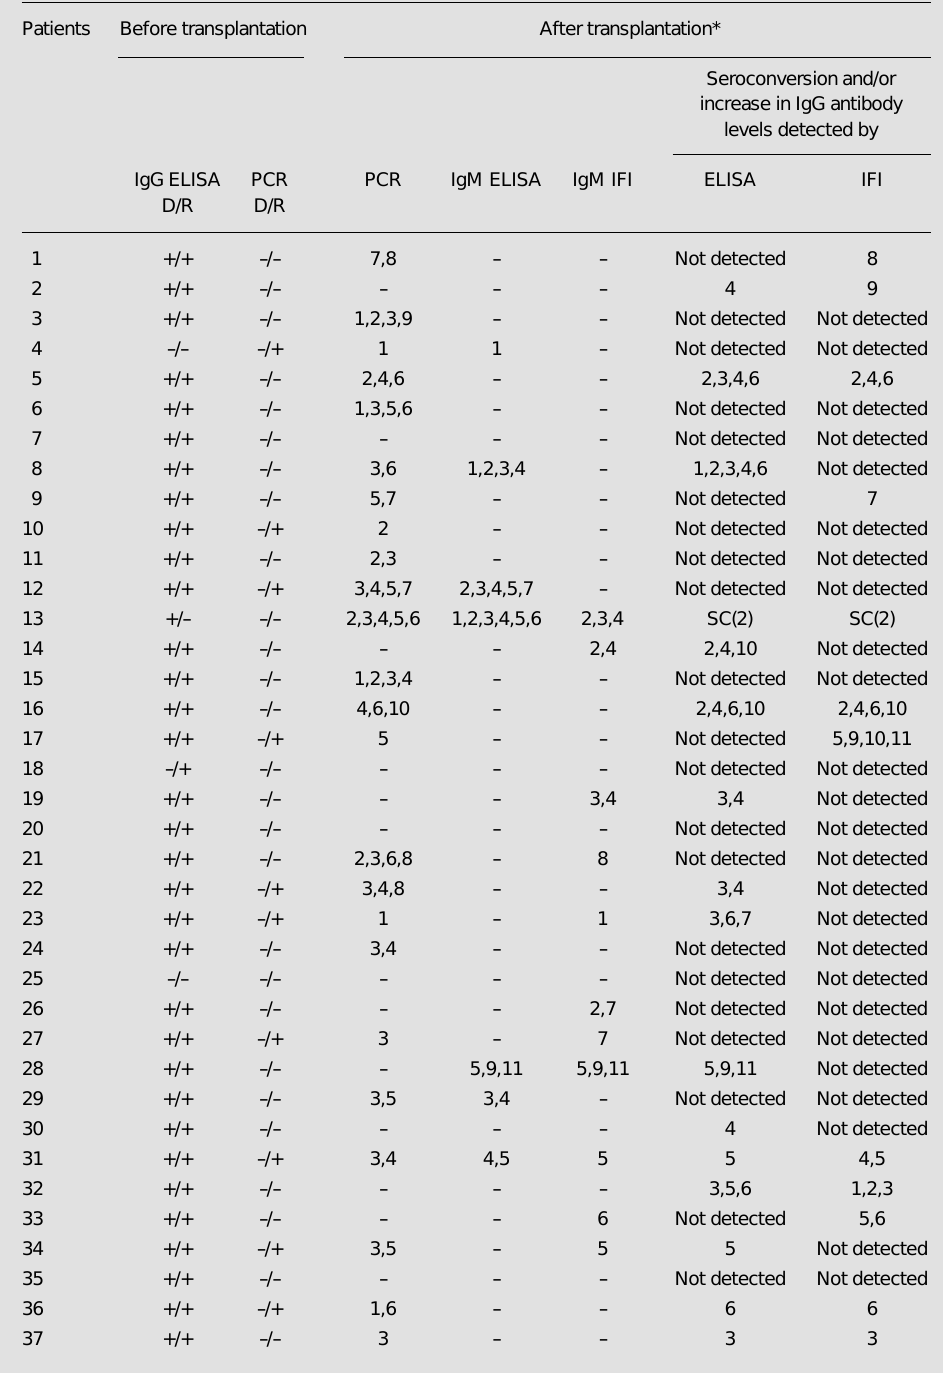
Table 1 - Results of serology (ELISA and IFI) and PCR on urine during follow-up of 37 kidney transplant patients who presented active CMV infection. D/R = Donor/receptor; + = positive reaction; - = negative reaction; *the numbers after transplantation indicate the months in which PCR and/or serology were indicative of active CMV infection; SC = seroconversion; Not detected = no seroconversion and/or increase in IgG antibody levels during follow-up.